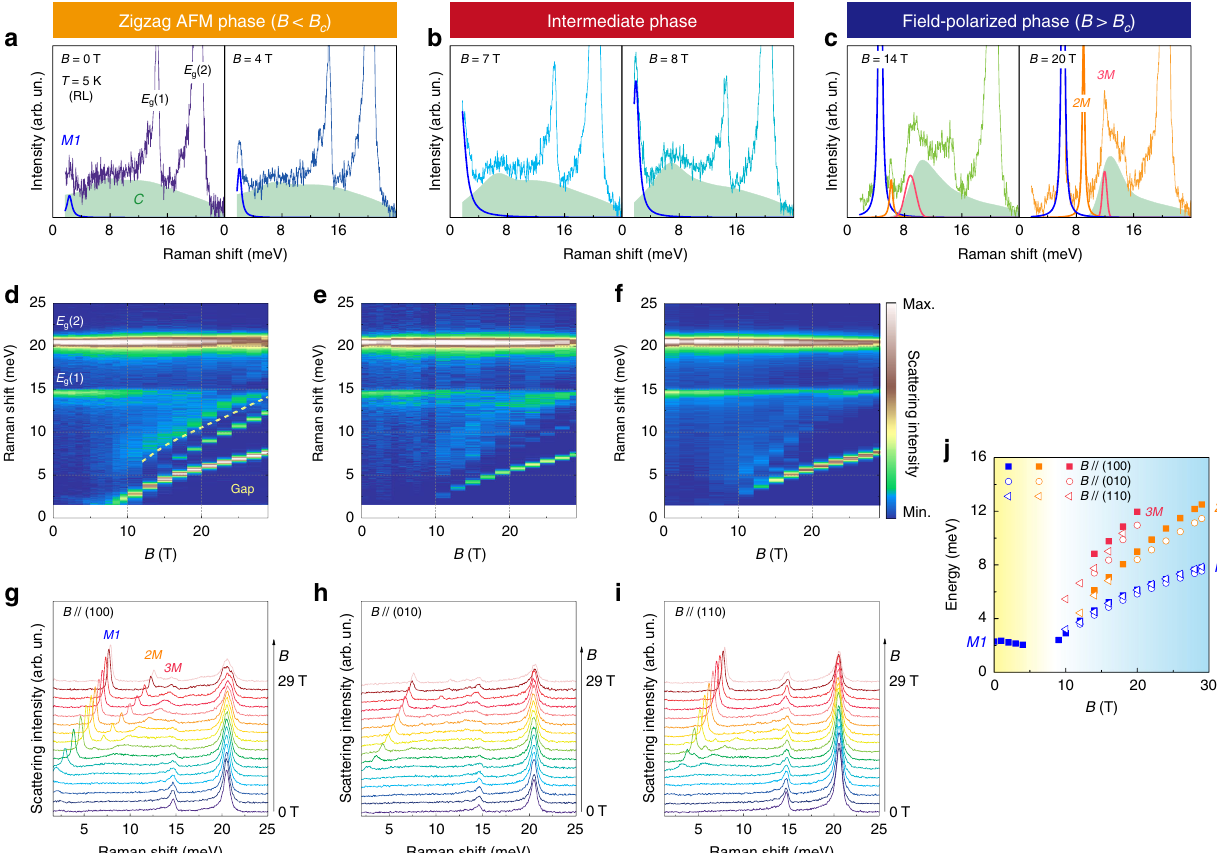
Fig. 1 Field evolution of magnetic excitations in α -RuCl 3 through fi eld-induced phases. a – c As-measured Raman spectra at T ≈ 5 K. For H // a , α -RuCl 3 passes successively from a zigzag antiferromagnetic- through an intermediate- to a fi eld-polarized-phase with increasing magnetic fi elds. The color shading denotes the broad continuum ( C ) on top of well-de fi ned sharp peaks of magnetic origin ( M1 , 2M , 3M ) and phonon modes ( E g (1) and E g (2)). d – f Color contour plots of the Raman scattering intensity evolution with magnetic fi elds aligned along (100), (010), and (110), respectively. The dashed line in d denotes the gap of the fractionalized continuum as a function of fi eld. g – i Respective sets of raw Raman data. j Field-dependence of the sharp low-energy magnetic excitations compared for different fi eld